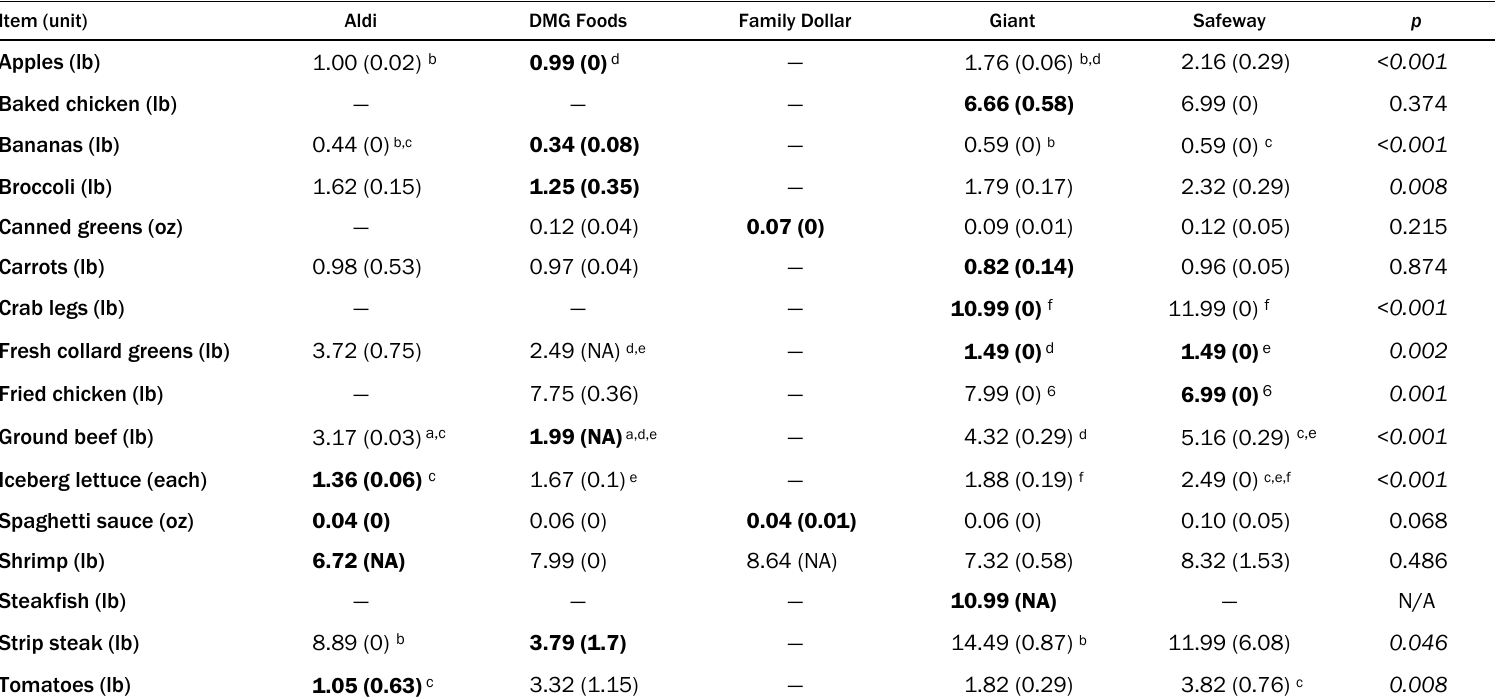
Table 1. Differences in the Prices per Unit of Top Salient Items by Store ( N =16), Measured by Three Consecutive Observations with Three-week